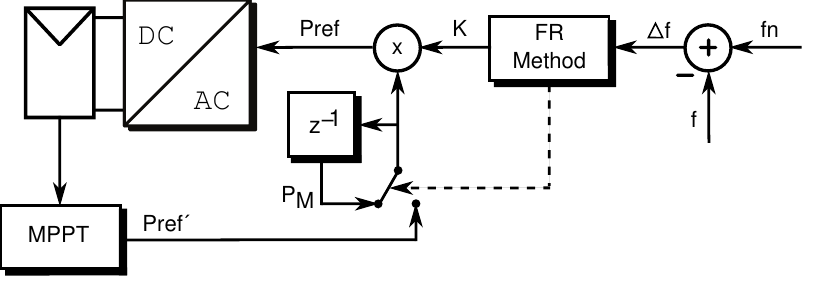
Figure 3. Converter resident FR scheme, maximum power point tracker (MPPT) output ( P ref ’) is modified by FR algorithm to provide a suitable current output power reference ( P ref